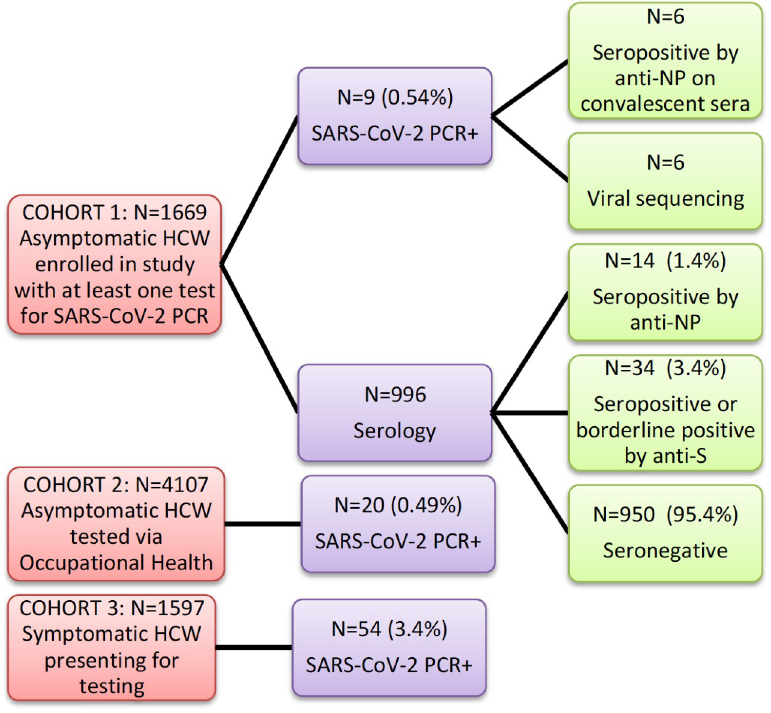
Fig 1. Study flow and outcomes. Abbreviations: HCW—healthcare workers, NP—nucleoprotein, S—spike.